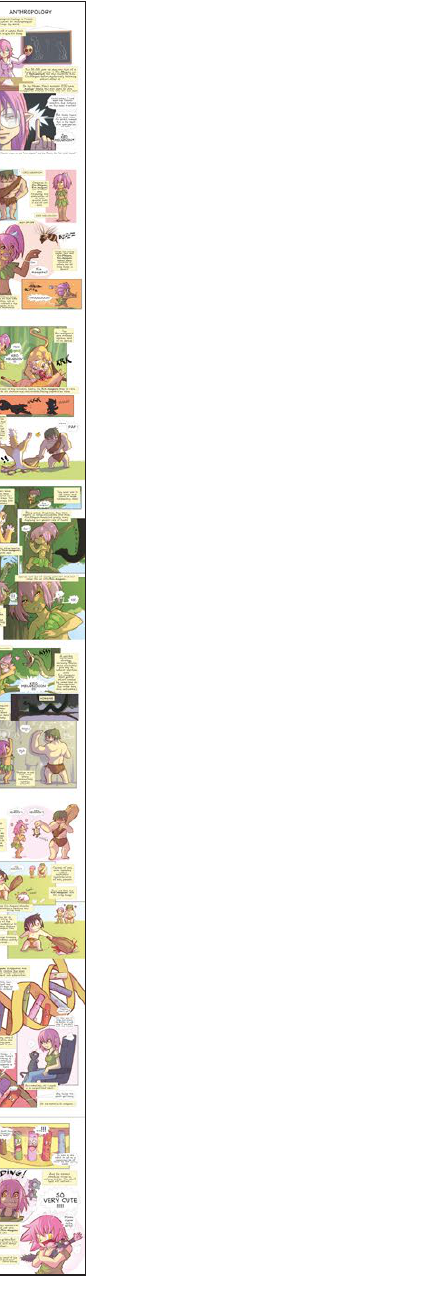
Figure 5: Visualization of a single installment of the Maliki webcomic. 9